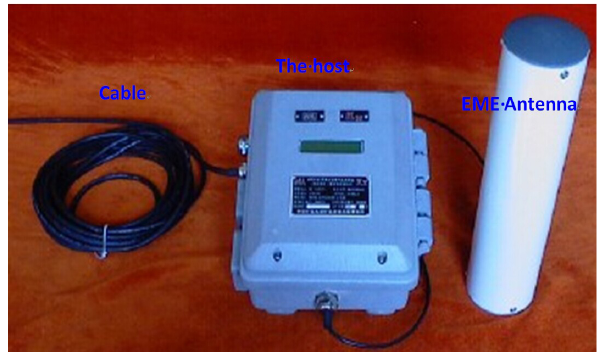
Figure 1. KBD7 EMR monitoring